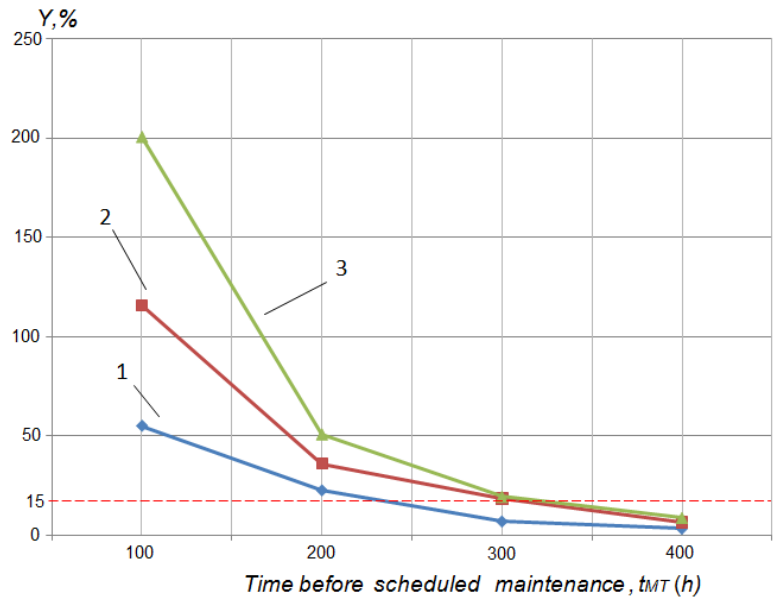
Figure 10. Task completion delay ratio Y : ( 1 ) t M = 24 h; ( 2 ) t M = 48 h; ( 3 ) t M = 72 h.